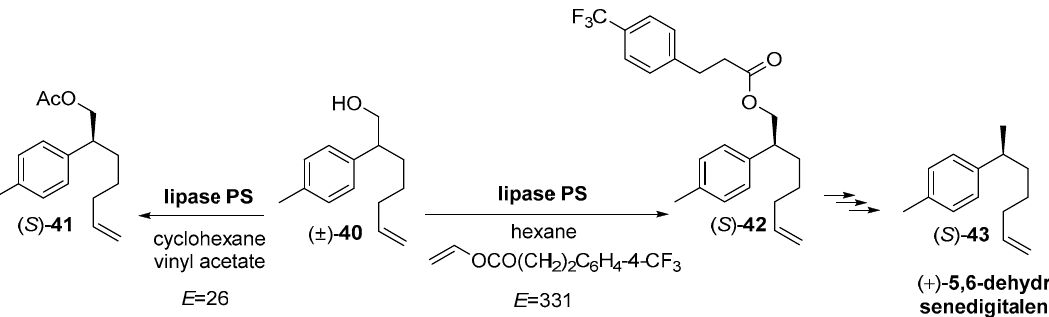
Figure 8. Lipase-mediated resolution of 2-aryl-heptanol 40 . The effect of the acylating agent on the enantioselectivity. Chiral building blocks ( S )- 42 was used for the synthesis of the norsesquiterpenes (+)-dehydrosenedigitalene ( 43 ).